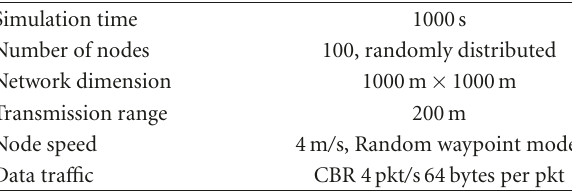
Table 1: Simulation parameters.